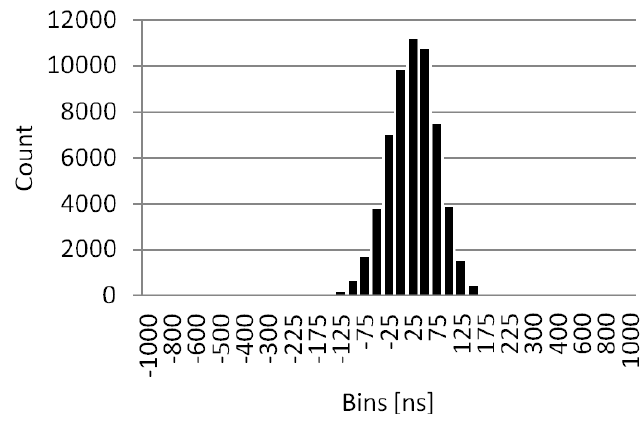
Figure 24. PPS signals offset histogram with PTP IEEE1588 using COTS Ethernet Switch with 100 Mbits traffic and VLAN